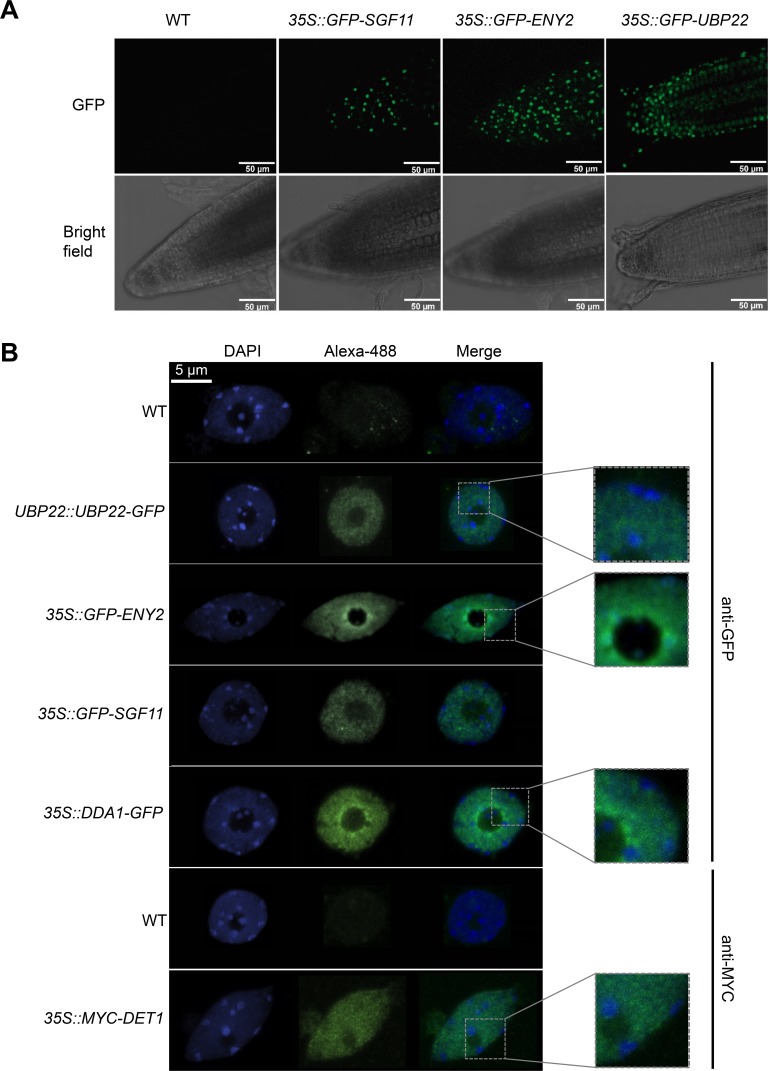
DET1, DDA1 and the UBP22 DUBm subunits are enriched in euchromatin whereas ENY2 is also found in heterochromatic foci.(A) Live imaging of root tips from 5-day-old seedlings showing the subcellular localization of GFP-tagged SGF11, ENY2 and UBP22 stably expressed in Arabidopsis. (B) Subnuclear localization of the indicated fusion proteins. In contrast to UBP22, SGF11, DDA1 and DET1 that displays a classical euchromatic distribution, GFP-ENY2 signals also frequently overlap with peri-nucleolar and peripheral heterochromatic structures. Representative confocal images of anti-GFP or anti-MYC immunodetection on isolated nuclei isolated from 5-day-old seedling cotyledons are shown. Insets show zoomed fluorescent signals.